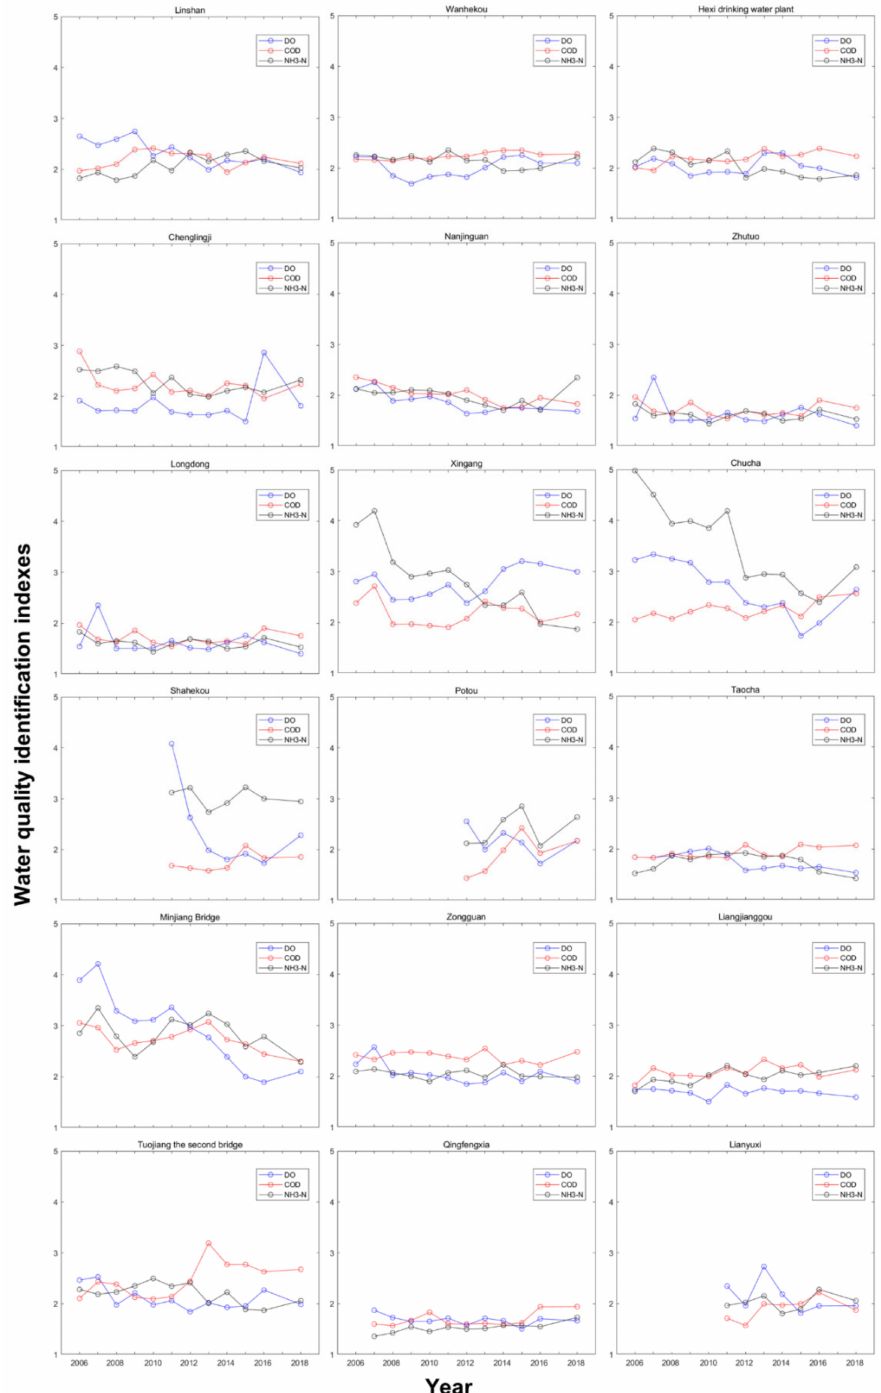
Figure 7. Annual changes in water quality identification indexes of different pollutants. The first seven sites are the trunk